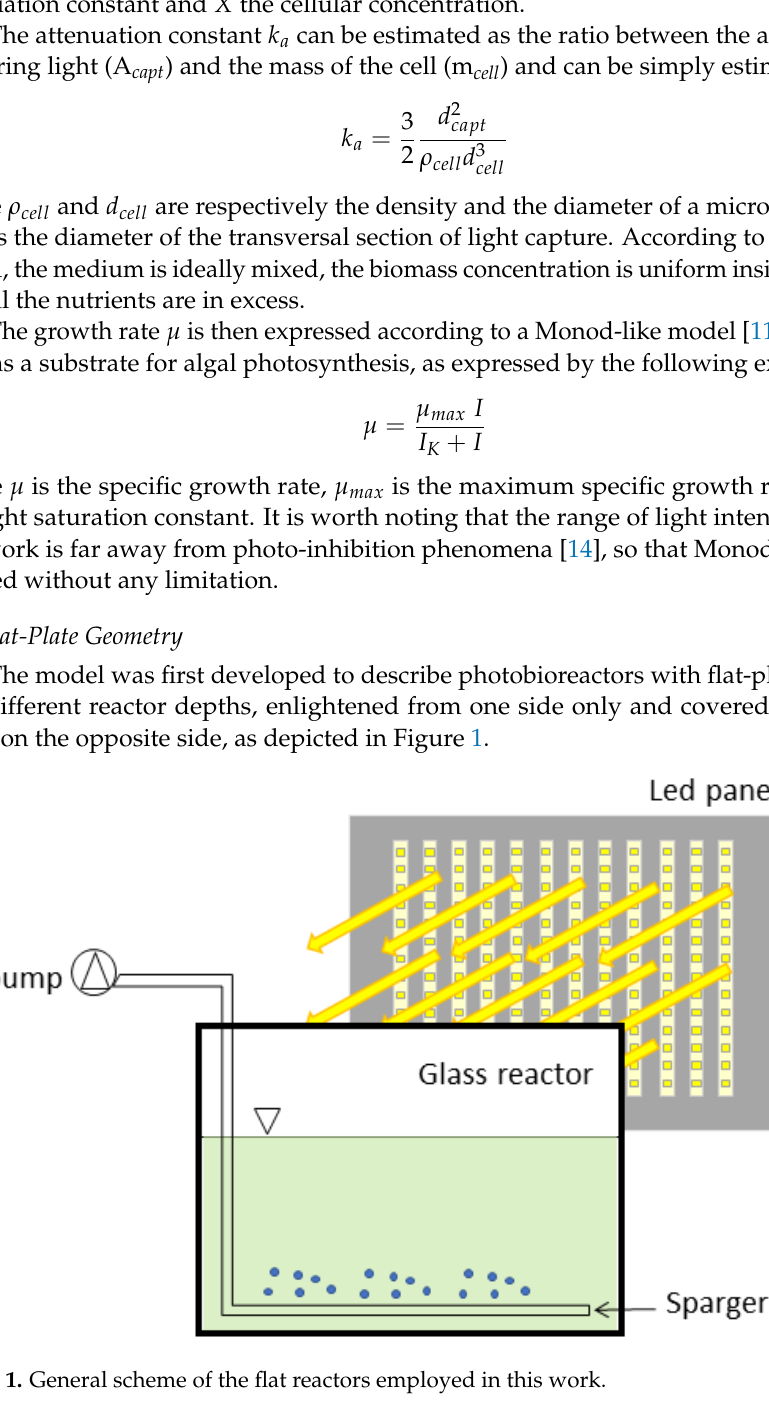
Figure 1. General scheme of the flat reactors employed in this work.